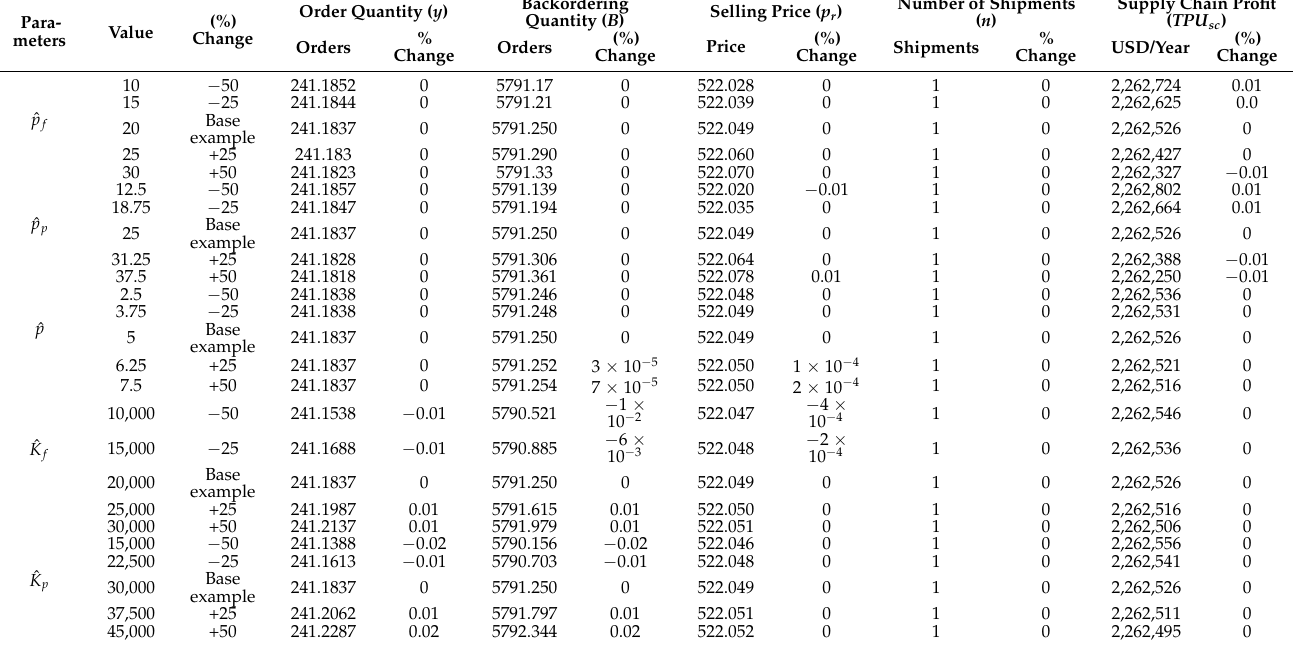
(cid:18) (cid:19) (cid:95) (cid:95) (cid:95) (cid:95) (cid:95) p p p , K f , K p , , on the optimal f p